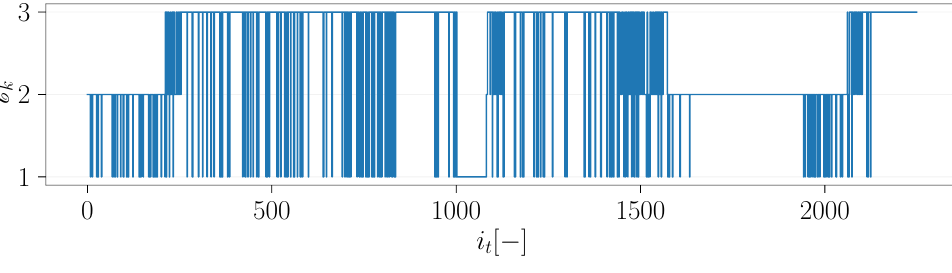
Figure 30. Assigned cluster C k over i t for setup 2.